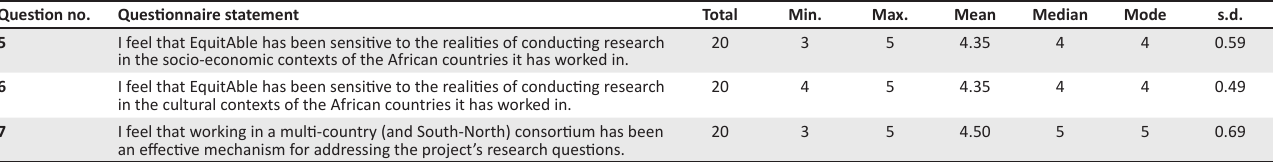
TABLE 2: EquitAble context issues.